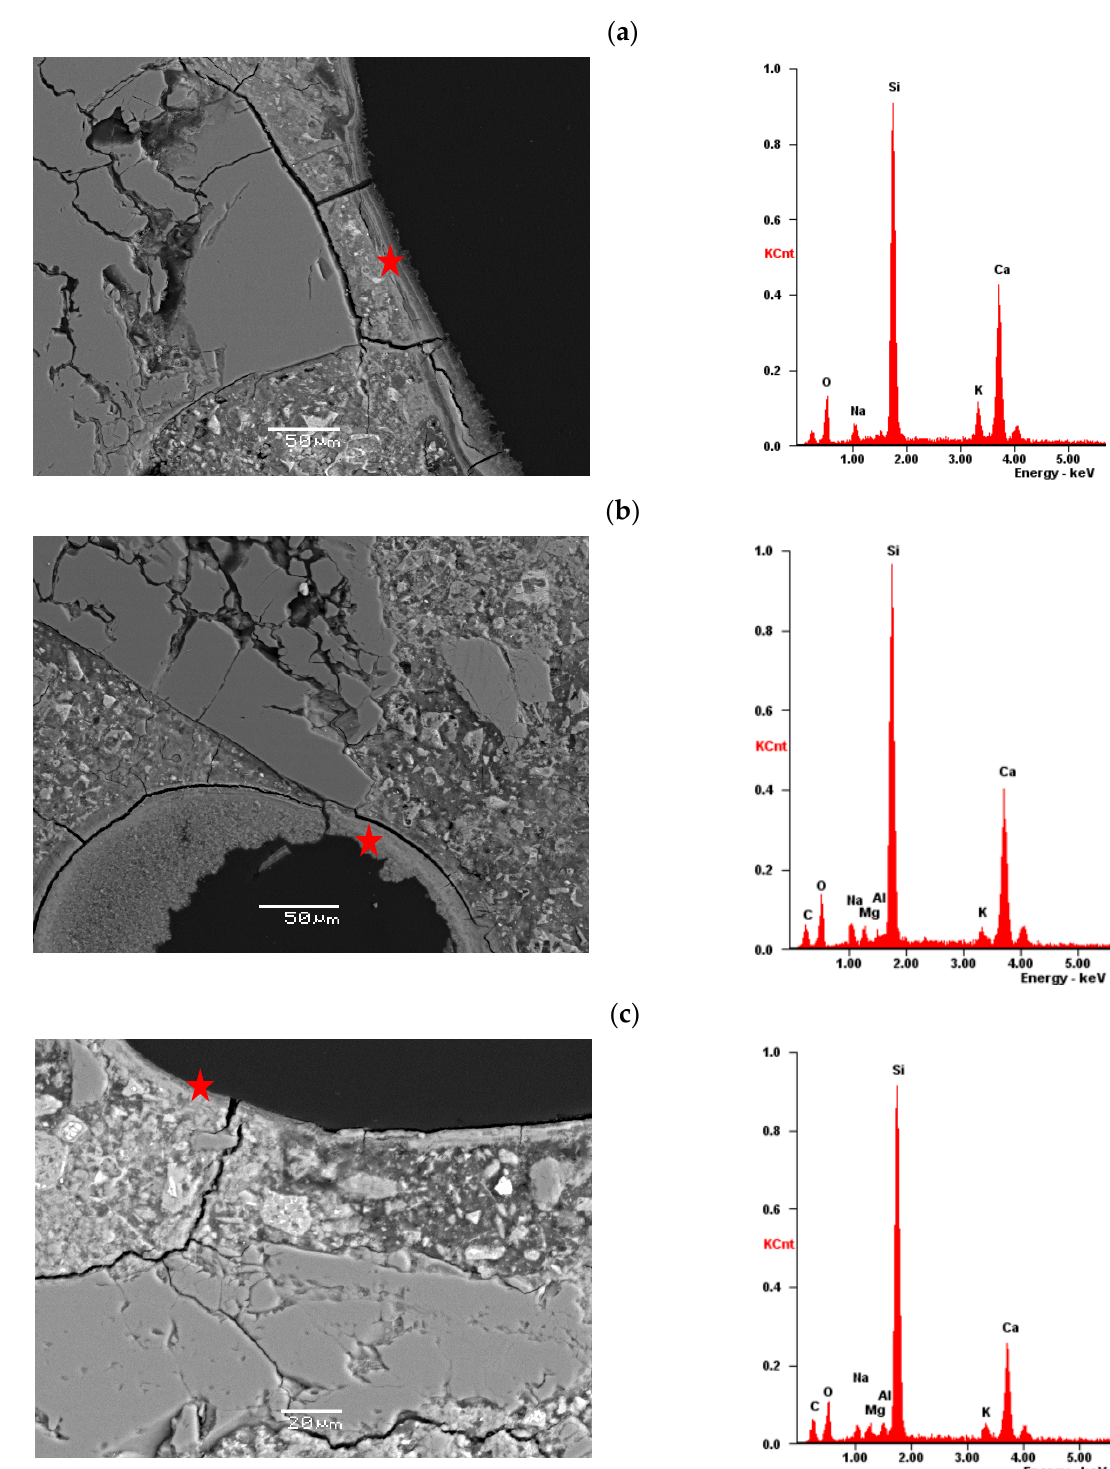
Figure 8. Cracked aggregate and ASR-gel formed in analyzed specimens: ( a ) reference, 0% of